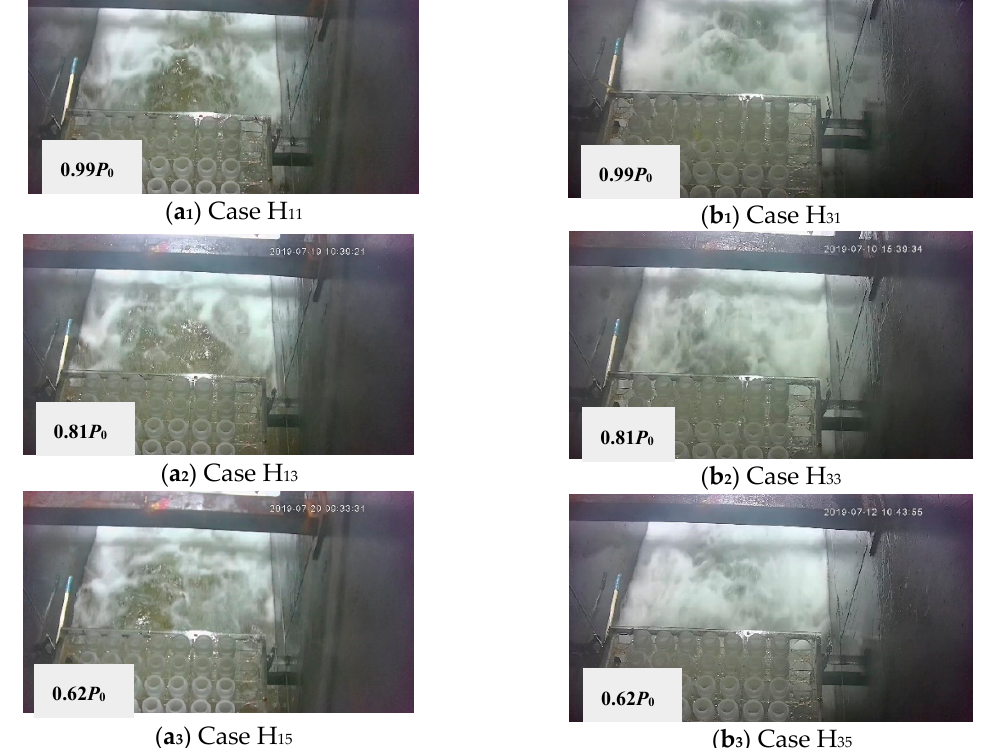
Figure 9. Downstream flow patterns in water cushion affected by low ambient pressure. ( a ) Q = 115.00 m 3 /h and V = 10.65 m/s; ( b ) Q = 125.00 m 3 /h and V = 11.57 m/s.